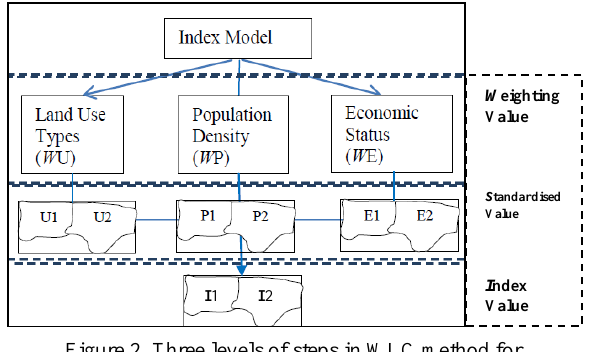
Figure 2. Three levels of steps in WLC method for selecting risk criteria (Modified from Chang, 2011)